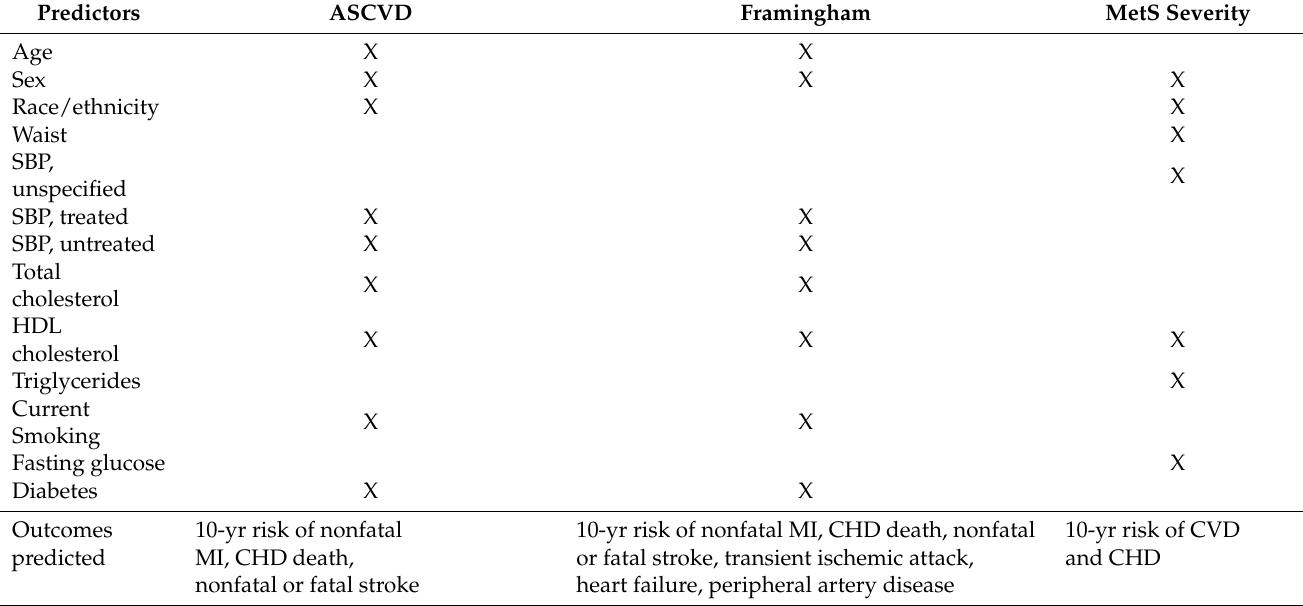
Table 1. Predictors and outcomes predicted for each CVD risk